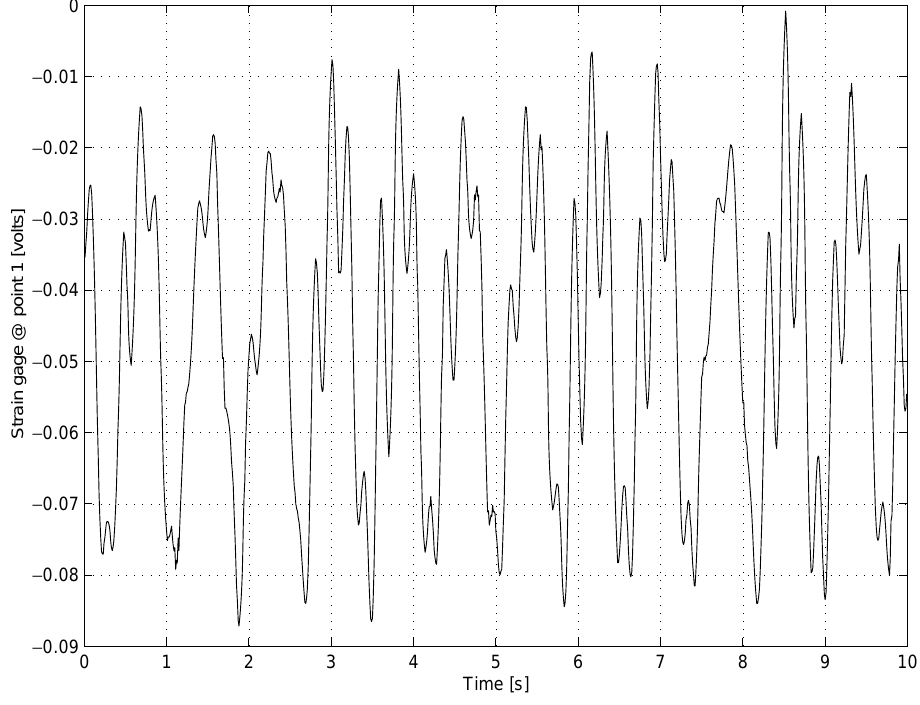
Fig. 2. Aeroelastic response time history (oscillatory